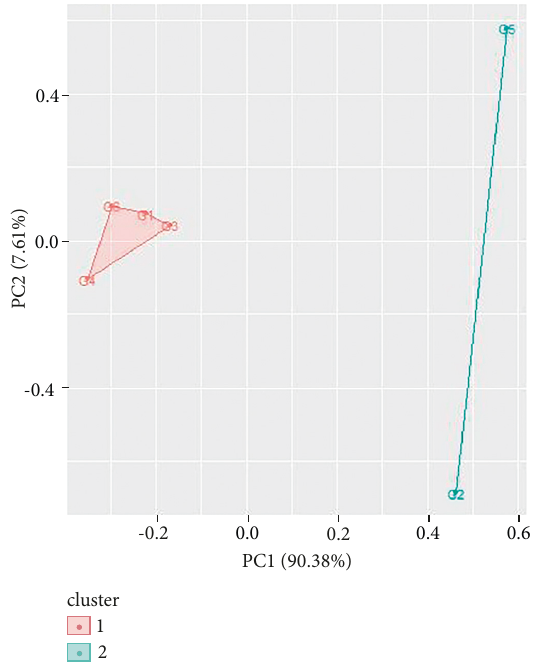
Figure 12: Cluster analysis for UV/Vis spectroscopy data for green ballpoint pen inks.